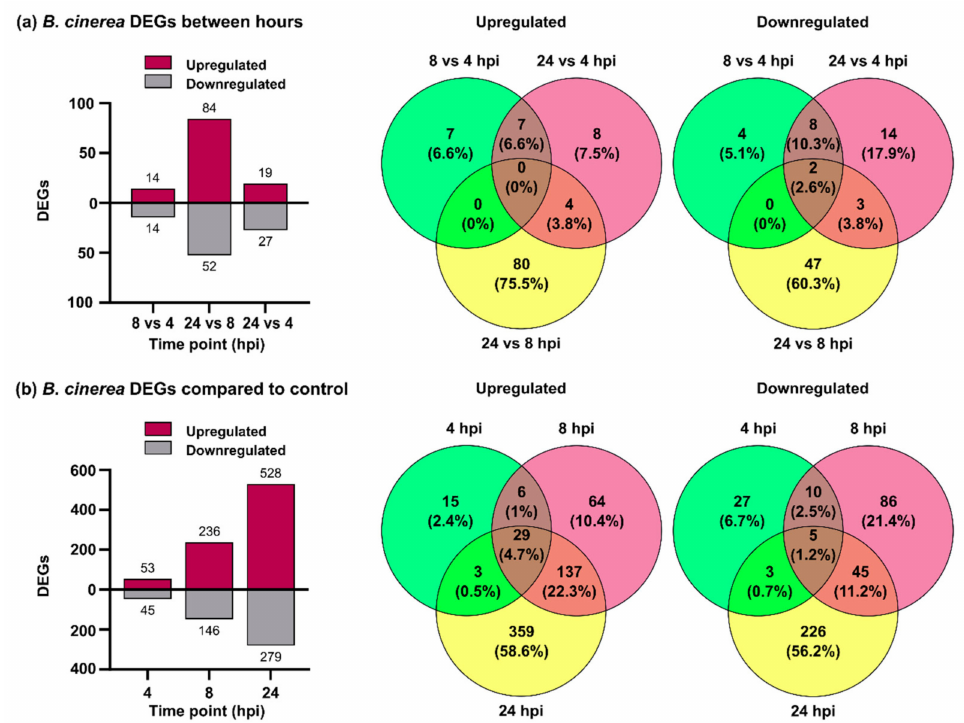
Figure 2. Differentially expressed B. cinerea genes during P. patens infection. ( a ) Number of differentially expressed genes (DEGs) and Venn diagrams from B. cinerea comparisons at 8 vs. 4 hpi, 24 vs. 8 hpi and 24 vs. 4 hpi. ( b ) Number of DEGs and Venn diagrams from B. cinerea at 4, 8 and 24 hpi compared with potato dextrose agar (PDA) samples. Log2 FC ≥ 2.0 or ≤ − 2.0 and false discovery rate (FDR) ≤ 0.05 were considered for DEGs identification. In Venn diagrams, the overlap of expressed fungal genes can be